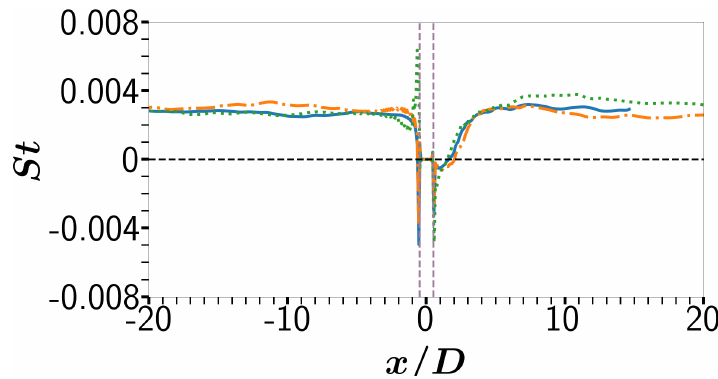
Figure 10. Streamwise variation of S t for Case 1, Case 2 and Case